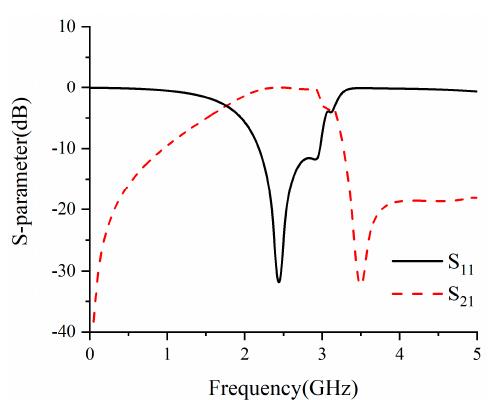
Figure 3. Layout of the band-pass filter.